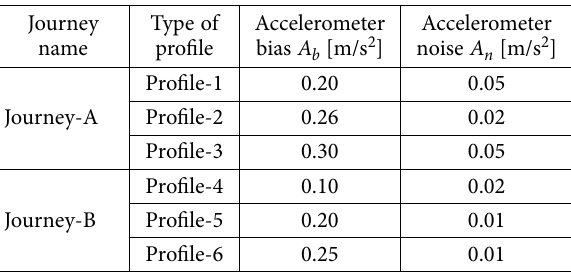
Table 2. Accelerometer bias and noise considered during the analysis for Journey-A and